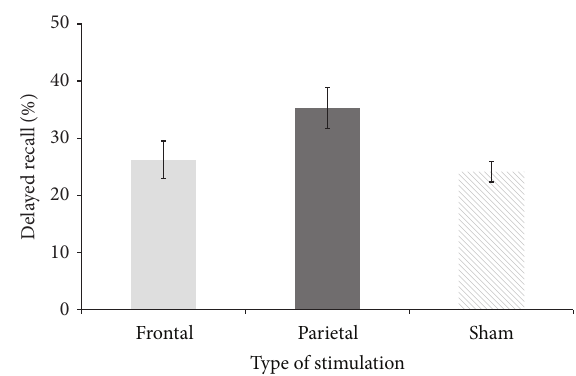
Figure 3: Average percentage of correctly recalled words after seven days (in the second session) across the three types of brain stimulation. Error bars represent the ±